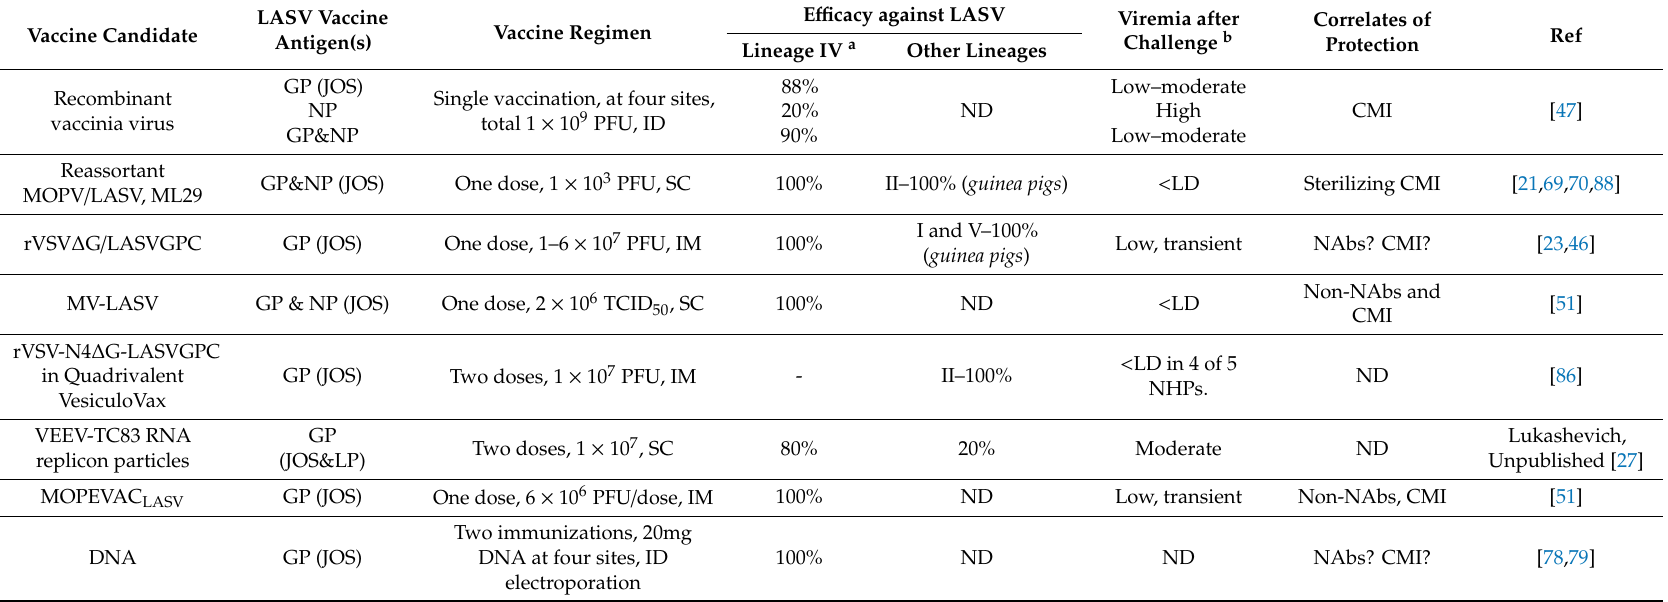
Table 4. Advanced LASV vaccine candidates tested in “proof-of-concept” e ffi cacy trials in non-human primates (NHPs). Vaccine